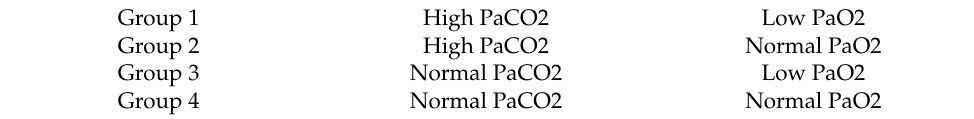
Table 1 legends: PaCO2—partial pressure of carbon dioxide in arterial blood, PaO2—partial pressure of oxygen in arterial